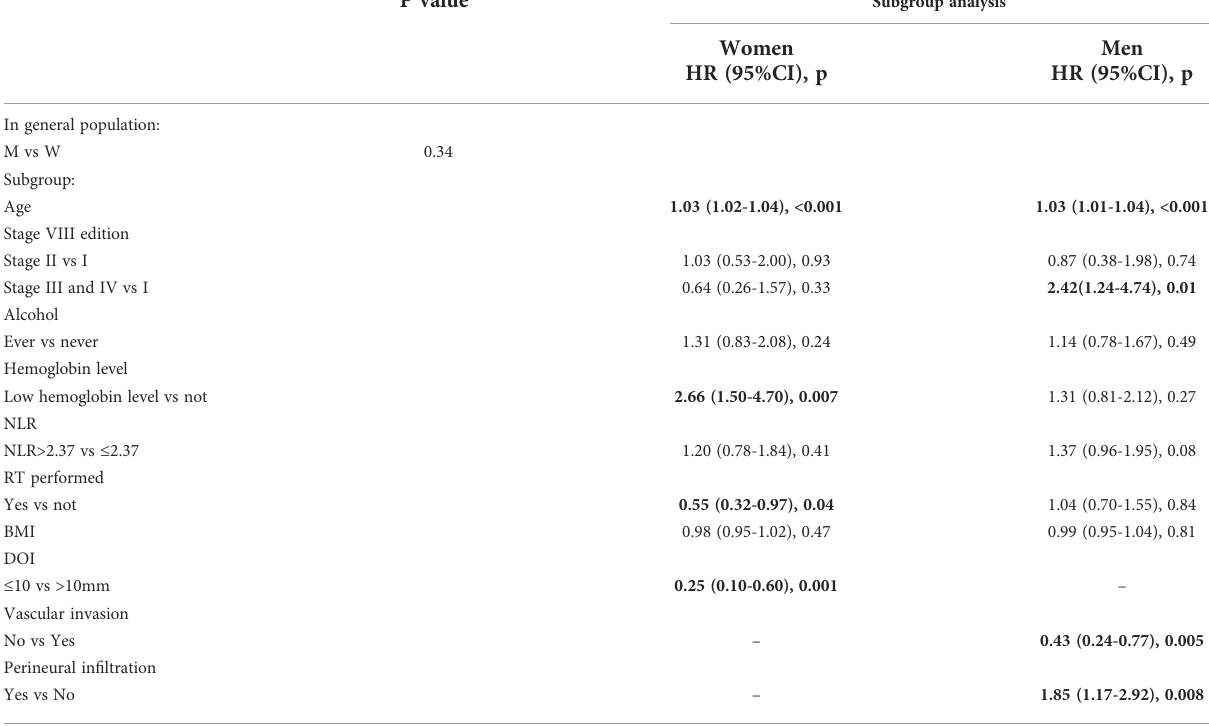
TABLE 2 Overall Survival (OS) for 576 patients, multivariate